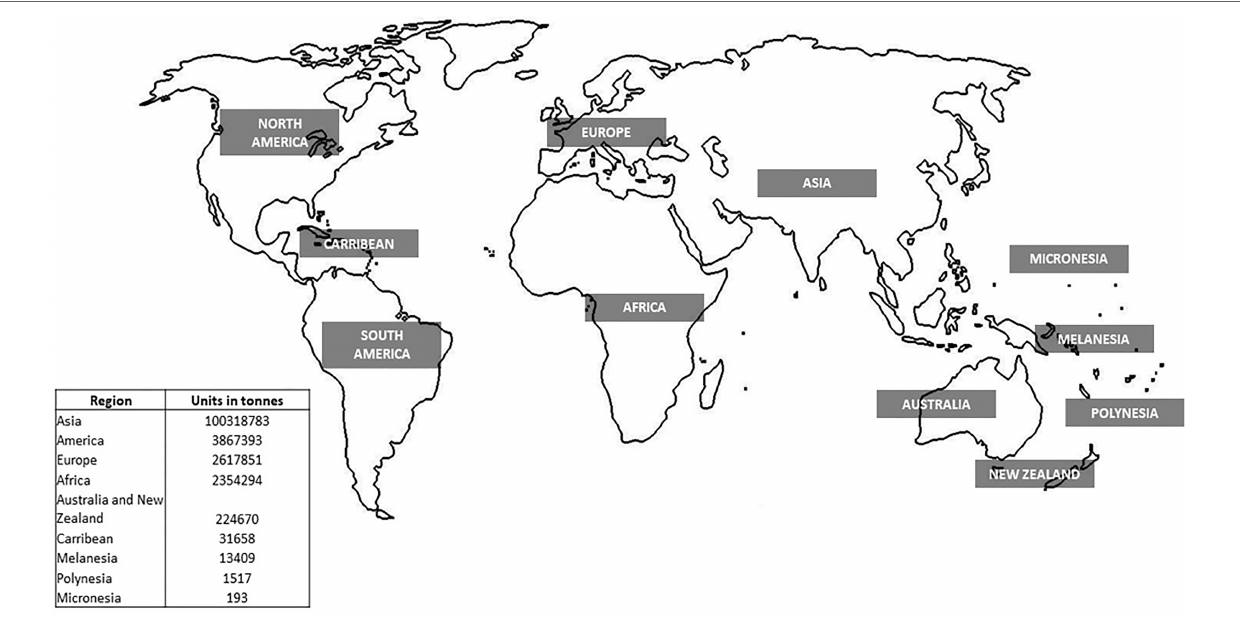
FIGURE 1 | Global aquaculture production in tons from 1990 to 2020 (FAO,